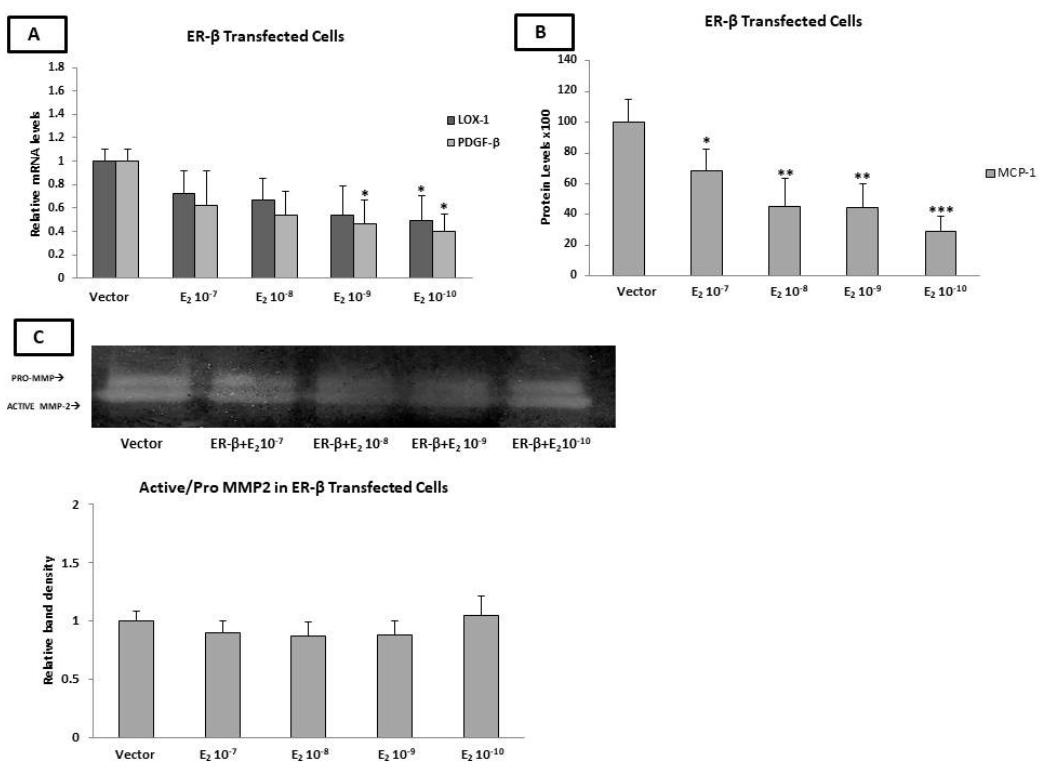
Figure 5. Effect of E 2 on the expression of factors involved in plaque stability in ER β -transfected HAECs. ( A ) Incubation of ER β -transfected HAECs with E 2 reduced the mRNA levels of LOX-1 (only at 10 −1 0 M of E 2 ) and PDGF- β (10 −9 and 10 −1 0 M of E 2 ). ( B ) Incubation of ER β -transfected HAECs with E 2 (10 −7 –10 −1 0 M) reduced MCP-1 protein levels. ( C ) Incubation of ER β -transfected HAECs with E 2 had no effect on MMP-2 gelatinase activity. The graphical data are represented as mean ± SD of at least three independent experiments (*** p < 0.001, ** p < 0.01, * p < 0.05). The i ncubation of ERβ -transfected HAECs with E 2 (10 −10 −10 −7 M) resulted in no sig-